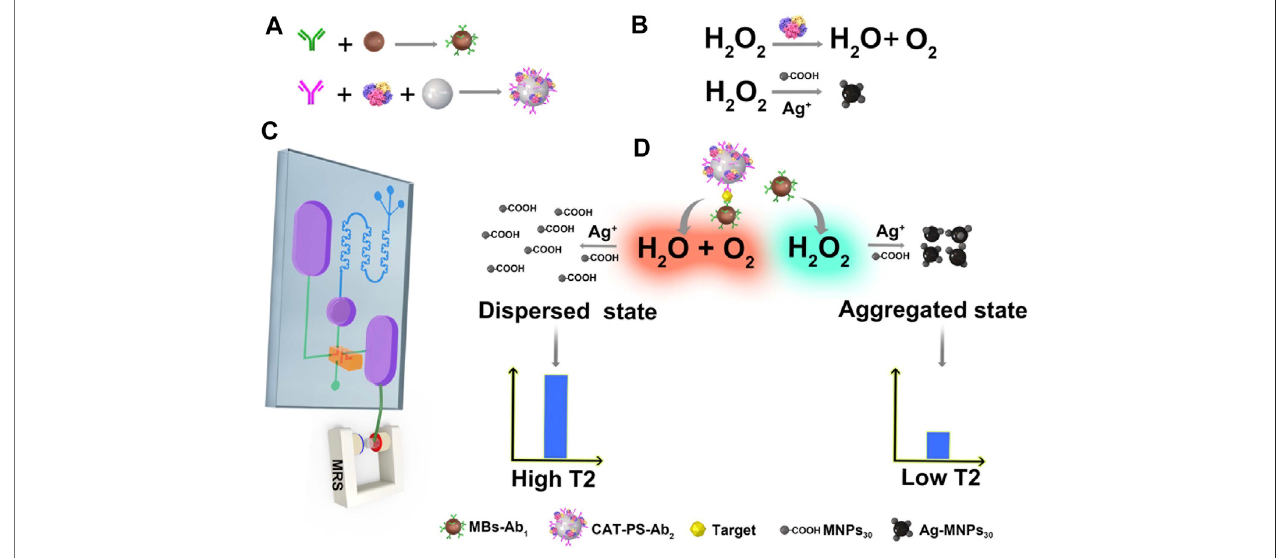
FIGURE1 | (A) Generation ofMBs labeled capture antibody (MBs-Ab1) and PSmicroparticle labeled both CAT and detection antibody (CAT-PS-Ab2). (B) Role of CAT in the formation of Ag-MNPs. (C) A micro fl uidic chip – based MRS immunosensor for biomarker detection. (D) CAT labeled on the surface of PS can catalyze H 2 O 2 and mediate the assembly aggregation of Ag-MNPs, which results in a lower NMR